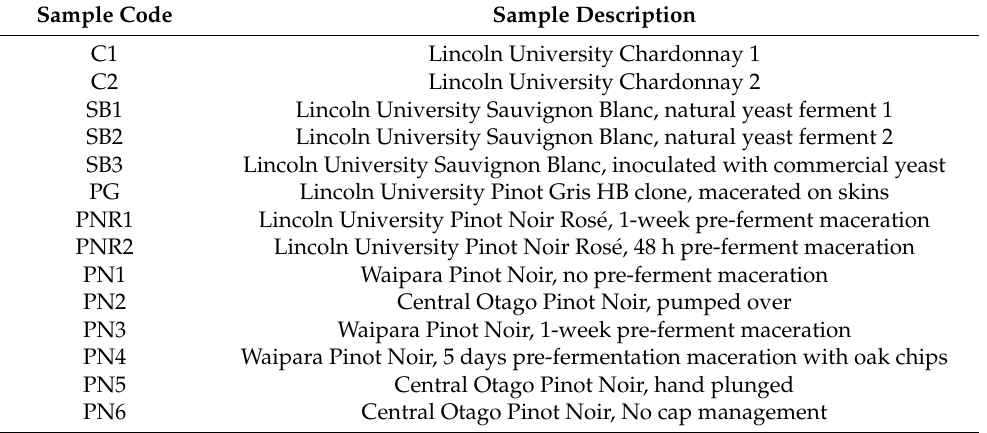
Table 1. Description of lees